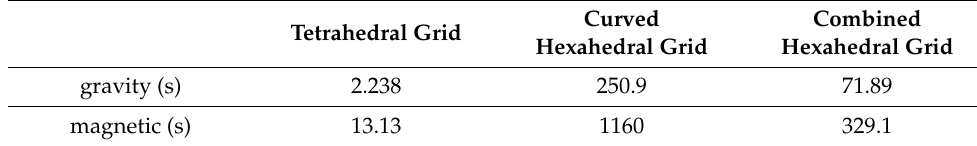
Table 5. Time cost of a single calculation of sensitivity matrix.